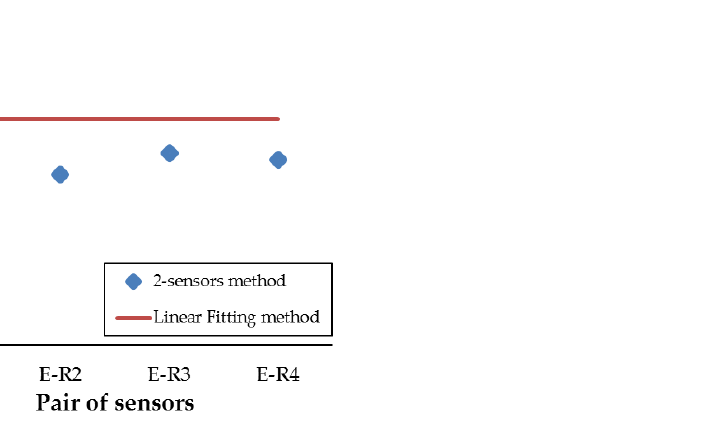
Table 2. Non-destructive testing results and strength grading.